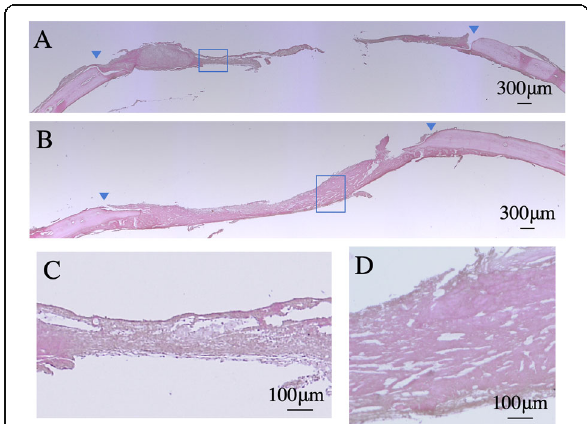
Fig. 4 Histological images of decalcified sections stained with hematoxylin-eosin at 1 week. a In the control. b In the test. Blue arrows show the original defect margins. c High magnification image of in flamed area in the control. d High magnification image of in flamed area in the test. The center of the sample was observed